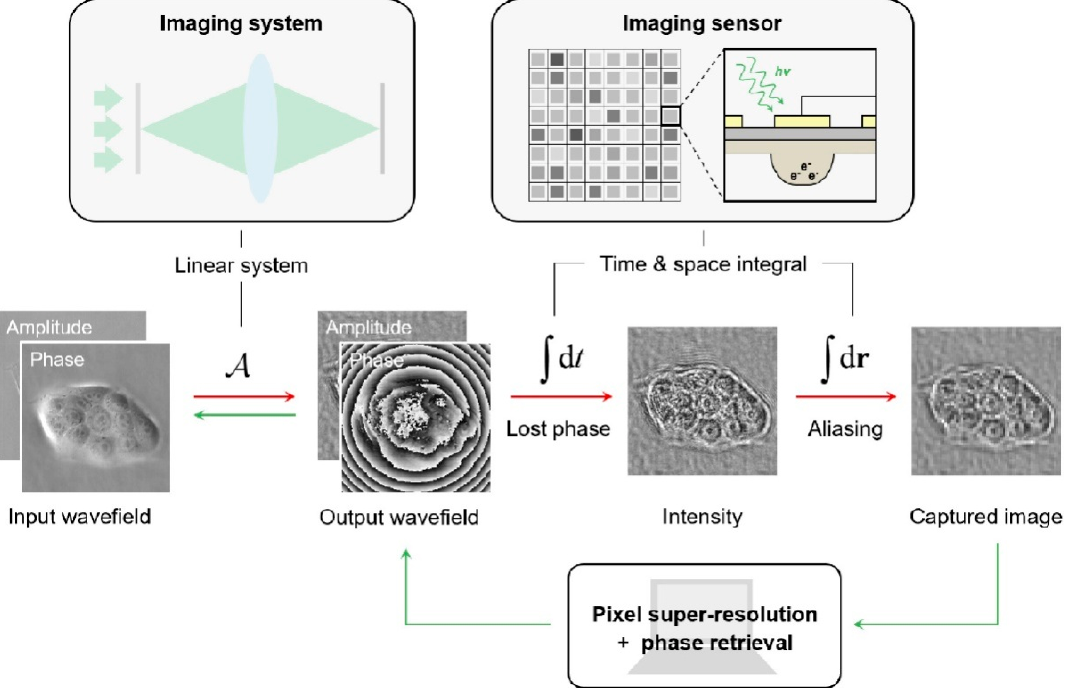
Figure 6. Diagram of the measurement and reconstruction process for in-line digital holography. A—phase difference, ∫ dt—time integral, ∫ dr—space integral [58].